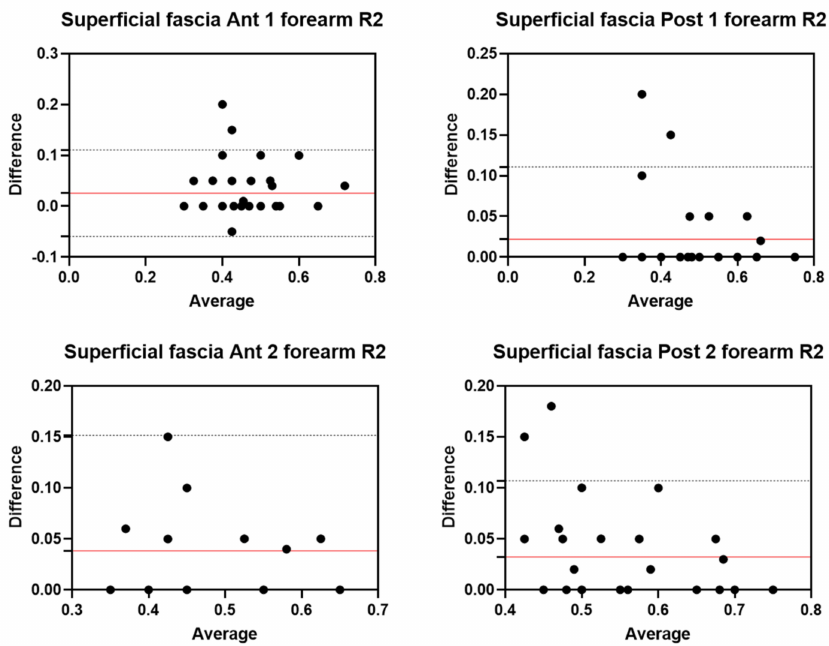
Figure 10. Bland–Altman plot comparing two sessions of Rater 2 (R2) measuring the US thickness of the superficial fascia of the forearm for the different levels. Red line = bias or mean difference; dashed lines: 95% limits of agreement (LoAs).